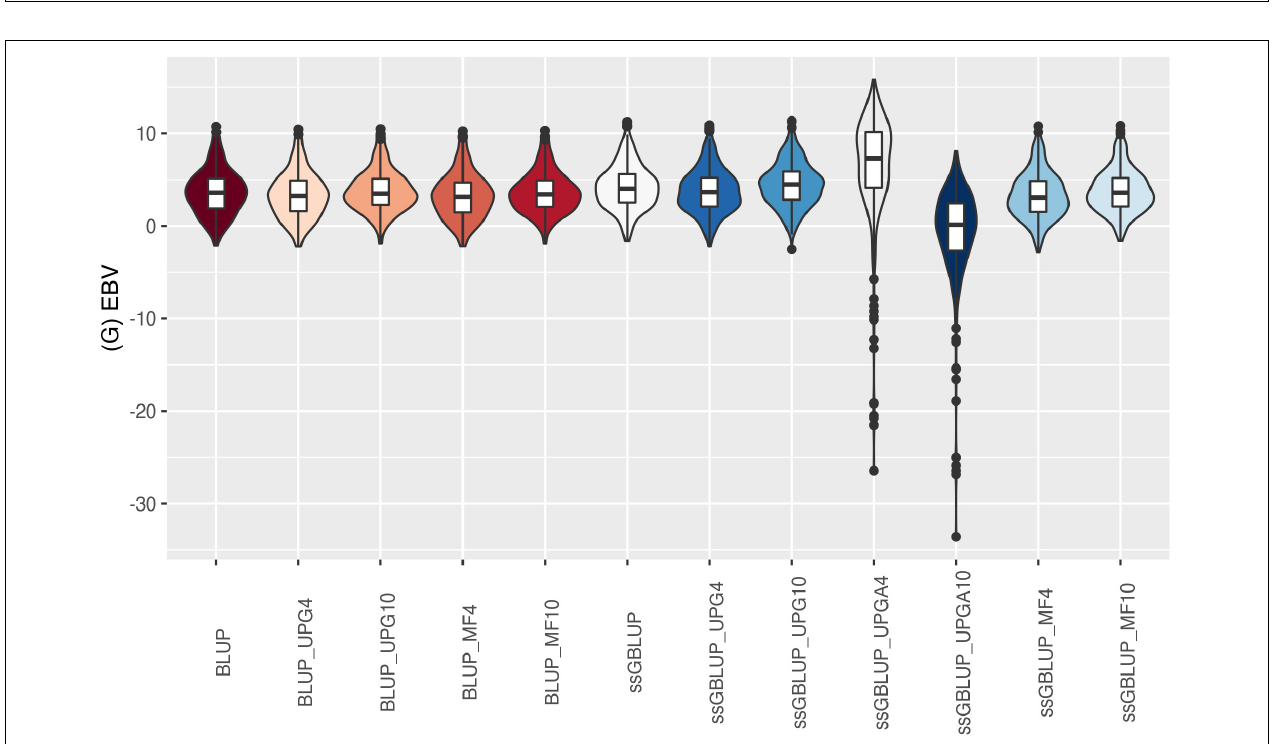
FIGURE 8 | (G)EBVs for validation animals for post weaning weight gain estimated using various models with and without genetic groups. (G)EBVs, (genomic) estimated breeding values.